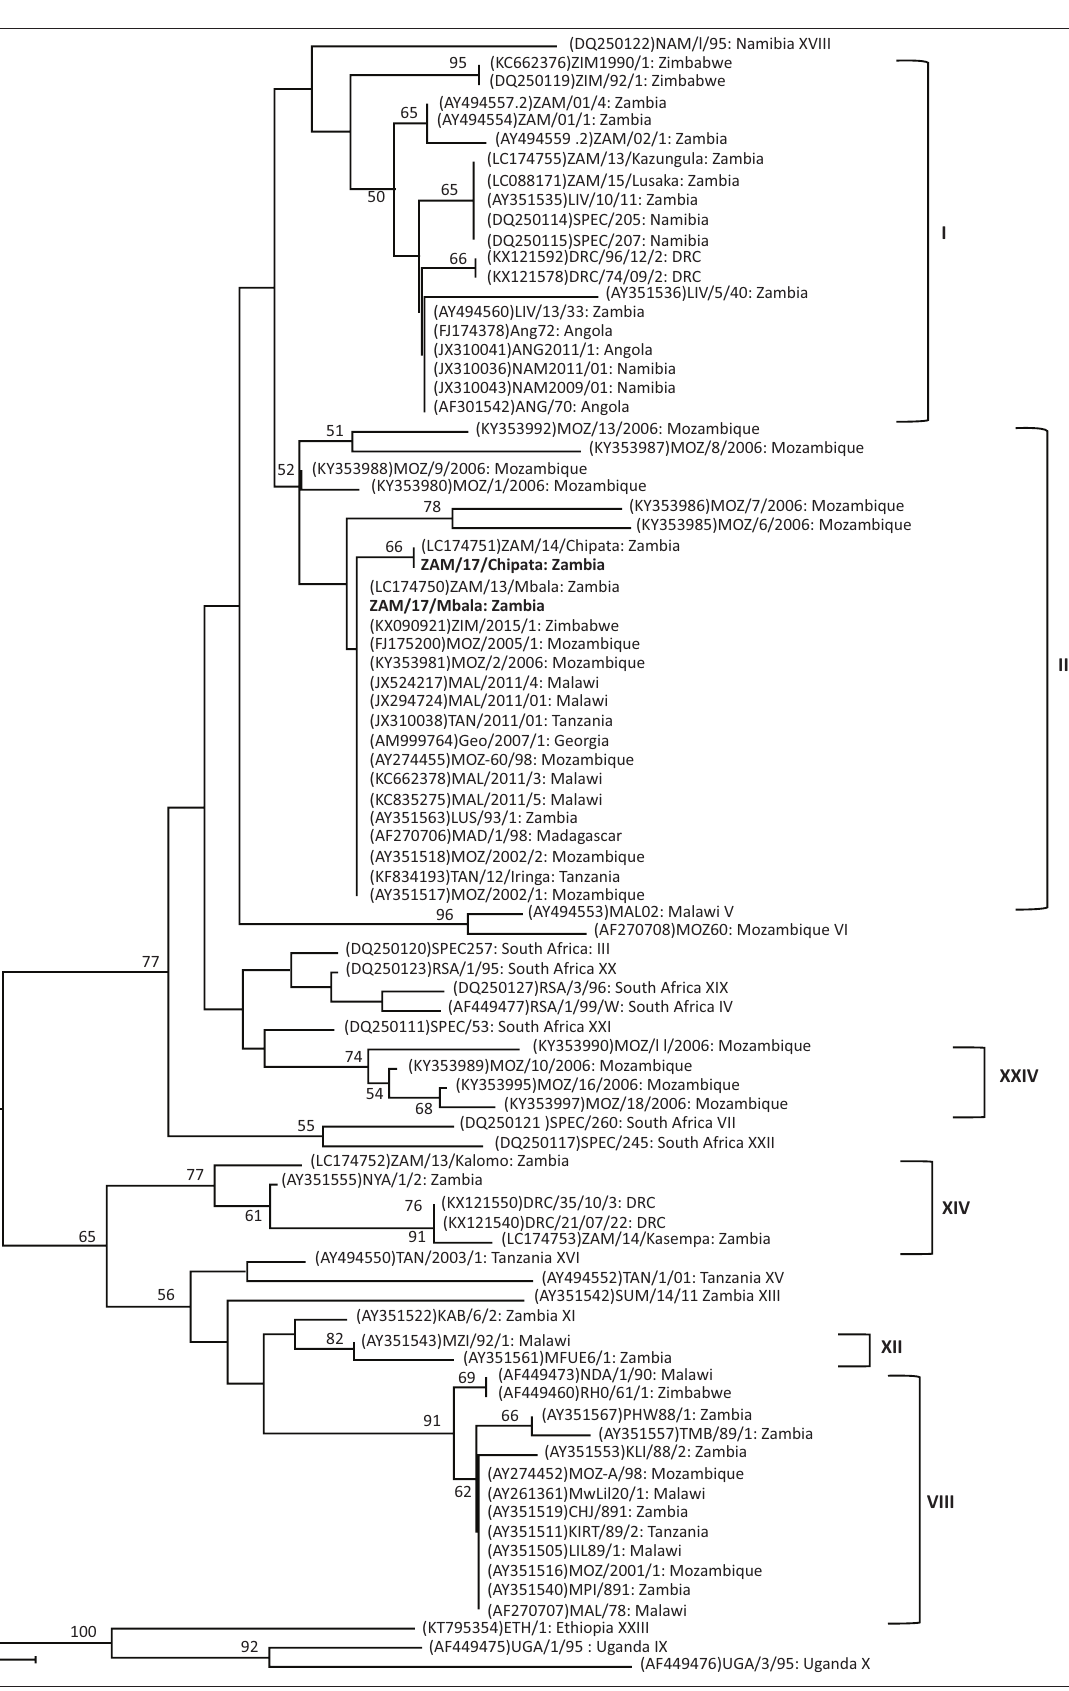
FIGURE 1: Phylogenetic relationships of the p72 gene of African swine fever viruses detected in domestic pigs during 2017 in Zambia. The evolutionary relationships were conducted by MEGA6 software using the neighbour-joining method, with evolutionary distances being computed by the p -distance method. Numbers at branch nodes indicate bootstrap values ≥ 50 % . The GenBank accession numbers of strains included in the analyses are indicated in parenthesis and the p72 genotypes are shown after the country of origin of the strains or the right bracket. Virus strains characterised in this study are in bold. Bar, number of substitutions per